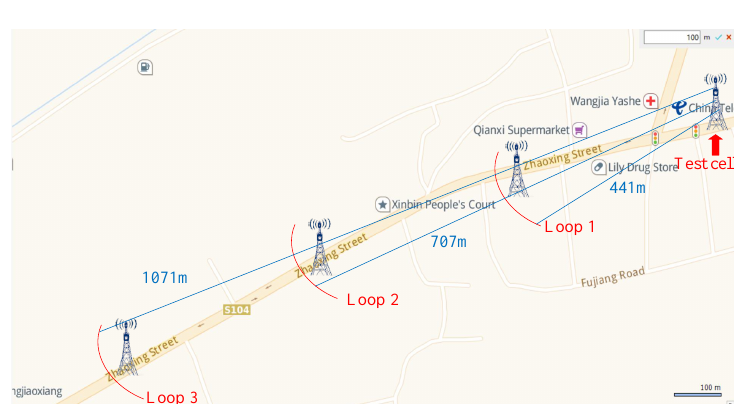
Figure 12. Test environment.